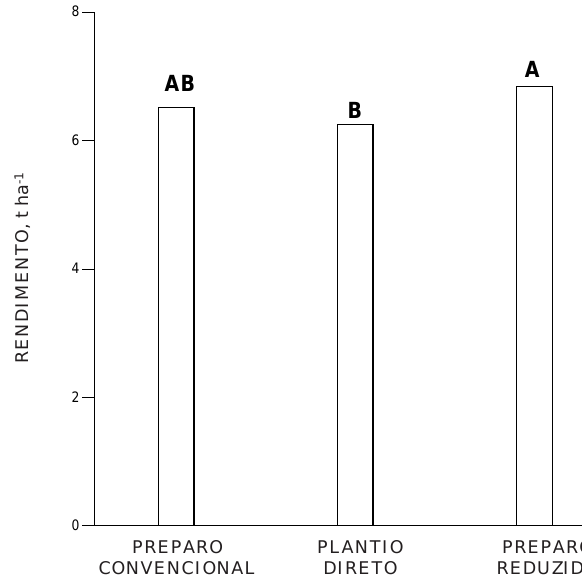
Figura 3. Rendimento do milho sob preparo convencional, plantio direto e preparo reduzido, na média de três sistemas de cultura e três doses de N, no ano de 1995/96. Colunas com a mesma letra não diferem estatisticamente entre si pelo teste Duncan (P > 0,05).